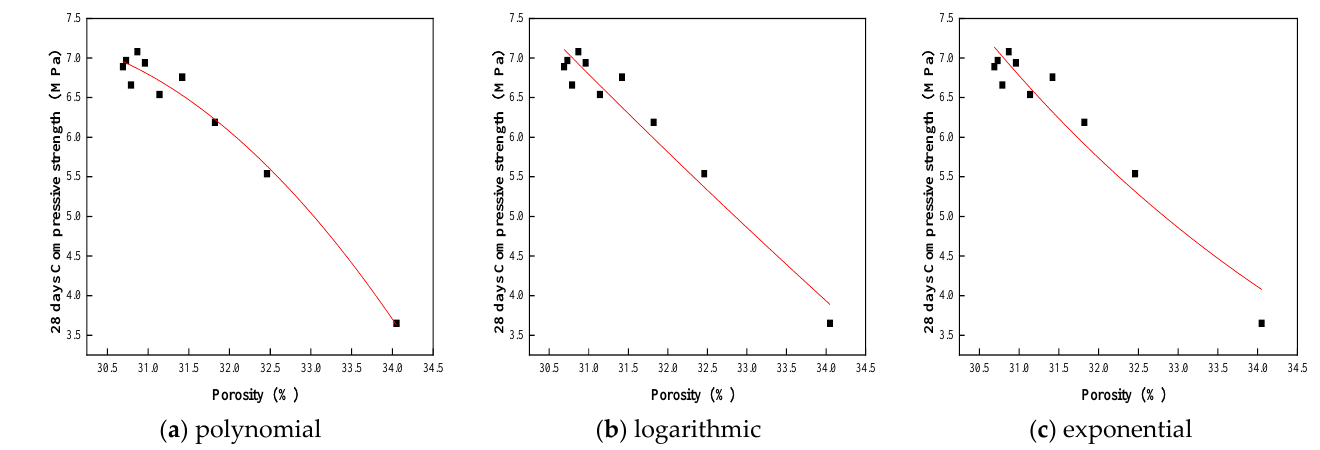
Figure 12. Fitting of curves for compressive strength versus porosity.